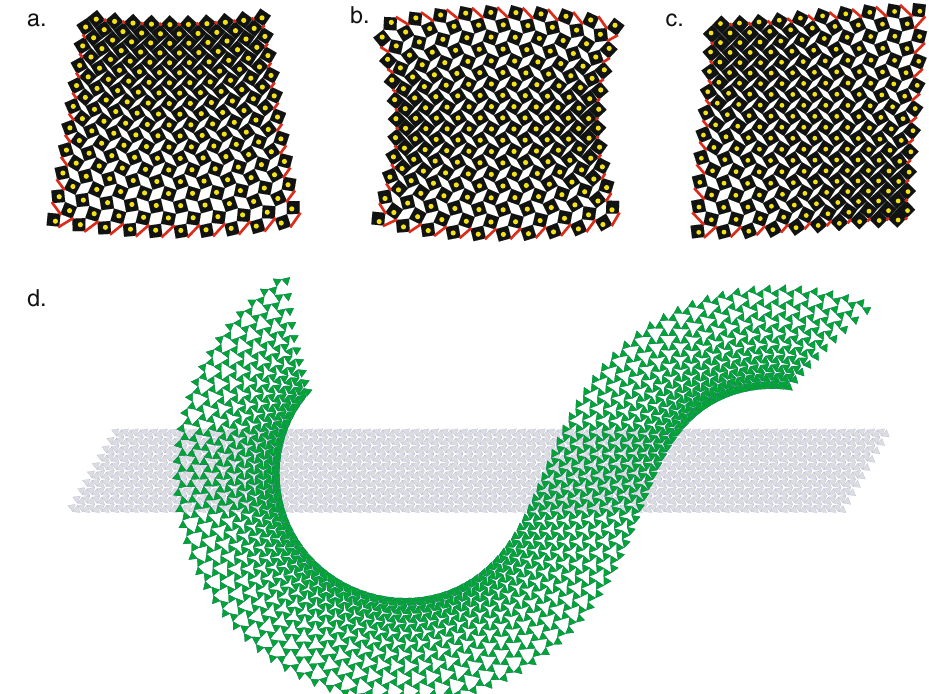
Fig. 4 Bulk-Boundary correspondence allows for precise control of metamaterial deformation. a – c The bulk-boundary correspondence shown in Fig. 3 enables on-demand actuation of material deformation via the addition of boundary springs (red). Here, the locations of square centers observed in simulation match well with analytically obtained target positions (yellow dots) for force-balanced con fi gurations of a simpli fi ed ball-and-spring model. d Because the principles presented here extend to any dilational metamaterial, the kagome lattice may likewise be placed in a low-energy conformal deformation. The kagome lattice is capable of undergoing a broader range of deformations without self-intersection, permitting a greater range of controllable deformations such as pictured